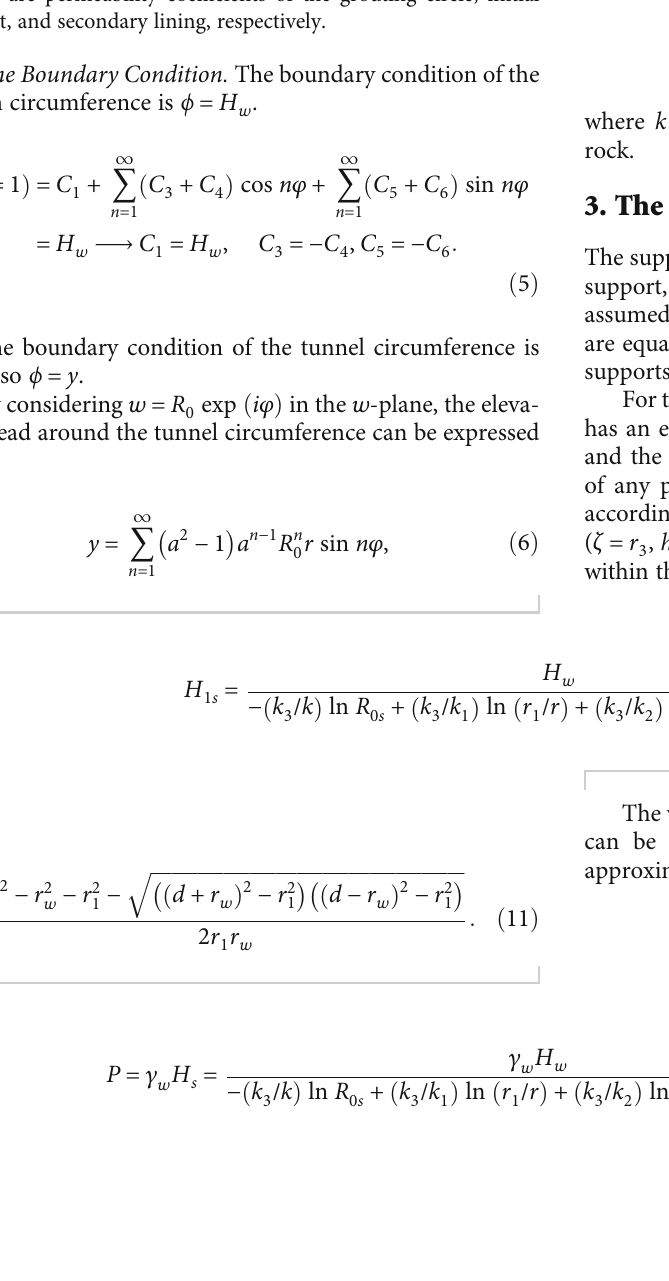
Figure 2: Relationships between lining structures. H pressure heads along the joints of the grouting circle and initial support circumference, the initial support and secondary lining circumference, and the secondary lining inner circumference, respectively. r 1 , r 2 , and r 3 are radii of the grouting circle, initial support, and internal of the secondary lining, respectively. k 1 , k 2 , and k 3 are permeability coe ffi cients of the grouting circle, initial support, and secondary lining,